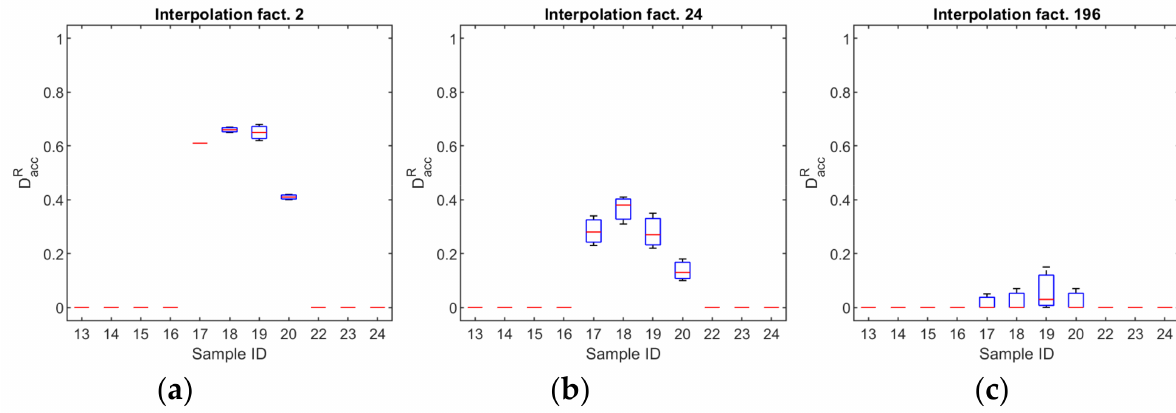
Figure 24. Absolute overall detection accuracy for the incorrect joint regarding the lack of fusion/penetration: ( a ) 2, ( b ) 24, ( c )